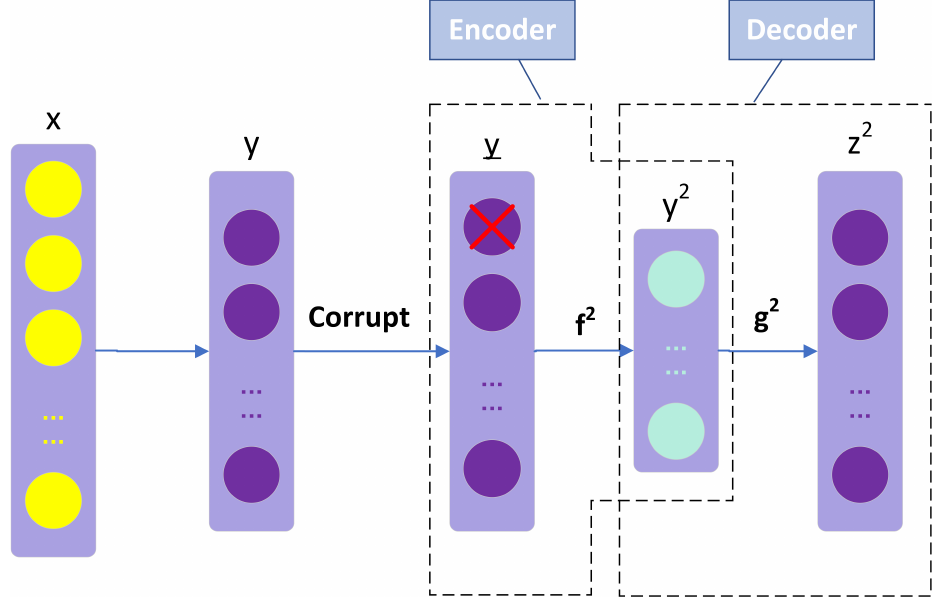
Figure 3. Schematic diagram of double denoising